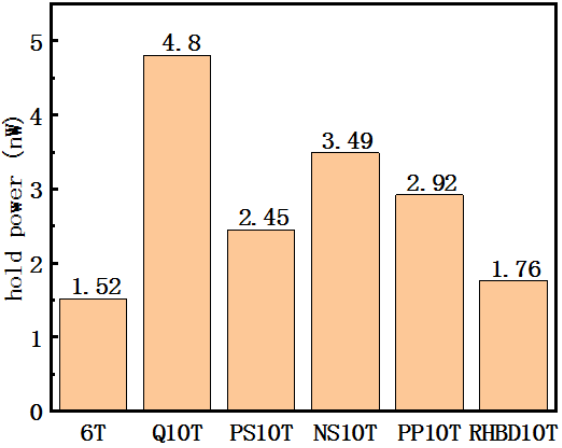
Figure 7. Hold power consumption comparison.